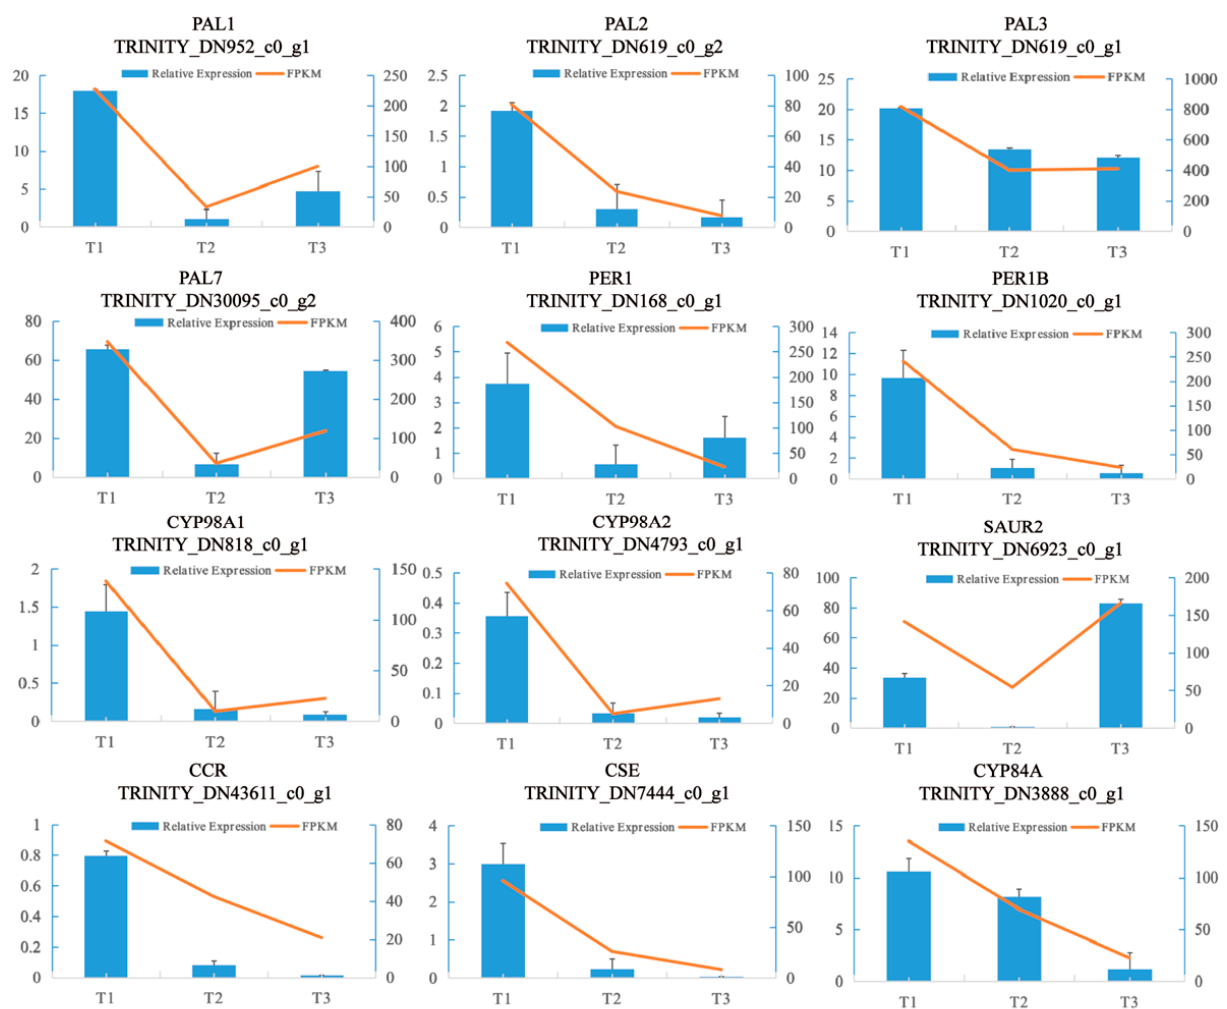
Figure 13. Verification of RNA-Seq sequencing data by the qRT-PCR assay. The left axis shows the relative expression, the right axis shows the fragments per kilobase million (FPKM) value, and the error line shows the SD value of the relative gene expression.